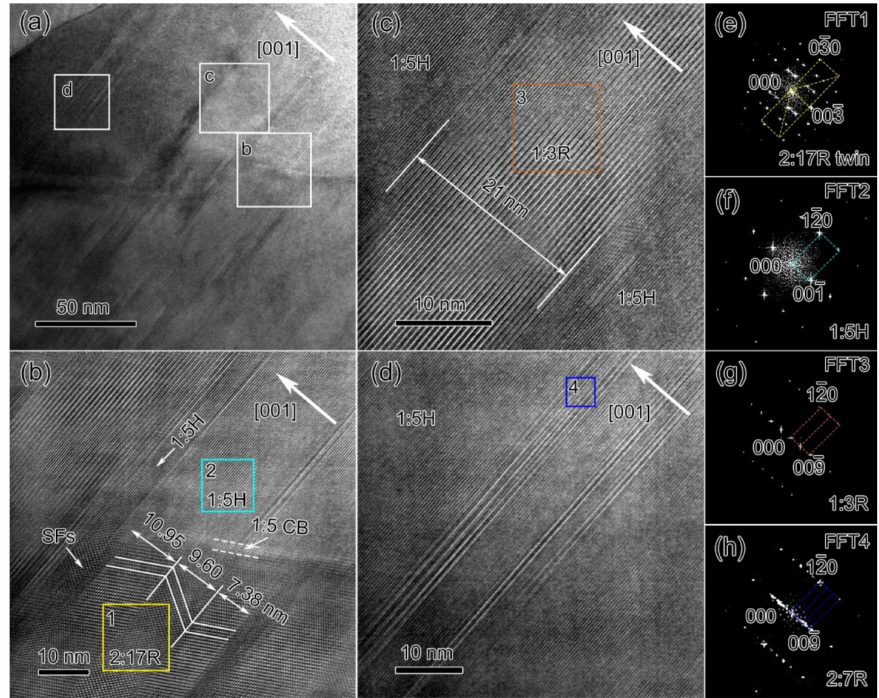
Figure 6. Bright-field image ( a ), HR-TEM images ( b – d ), and FFT patterns of 2:17R twin ( e ), 1:5H precipitates ( f ), 1:3R precipitates ( g ), and 2:7R precipitates ( h ) at the grain boundaries for